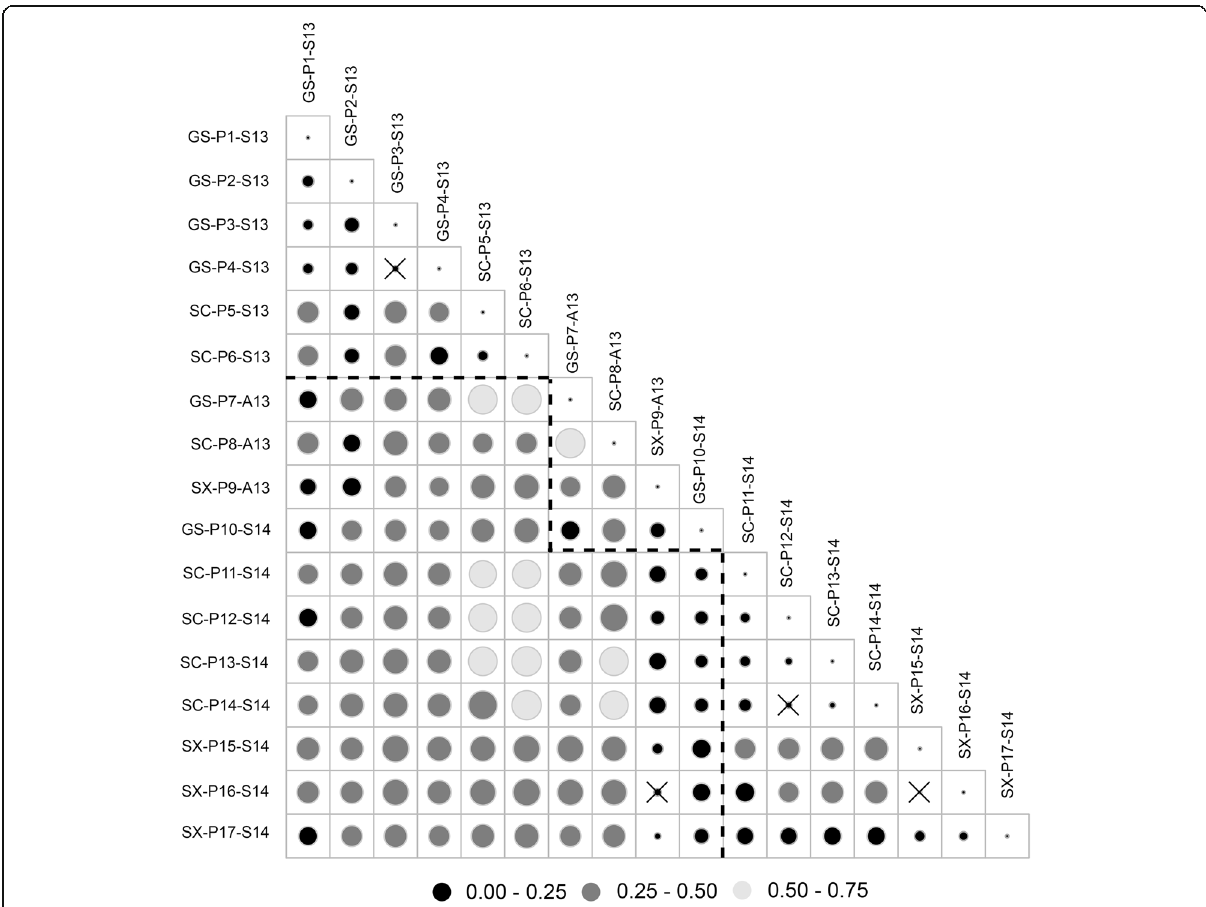
Fig. 3 Pair-wise φ pt among 17 subpopulations of Puccinia striiformis f. sp. tritici in this study. The larger the circle the larger the φ pt value was, and the black, dark gray and light gray colors of circle represent the φ pt level range of 0 – 0.25, 0.25 – 0.5, and 0.5 – 0.75, respectively. A “ X ” indicated the differentiation between the paired subpopulations was insignificant at P =